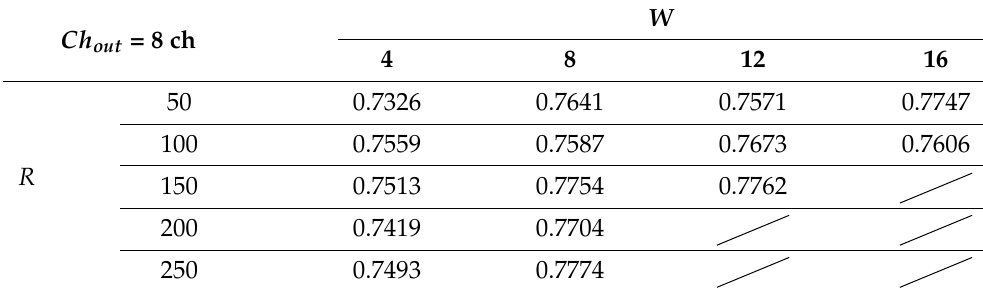
Table 10. Accuracy of parameter search at Ch out = 8 ch.